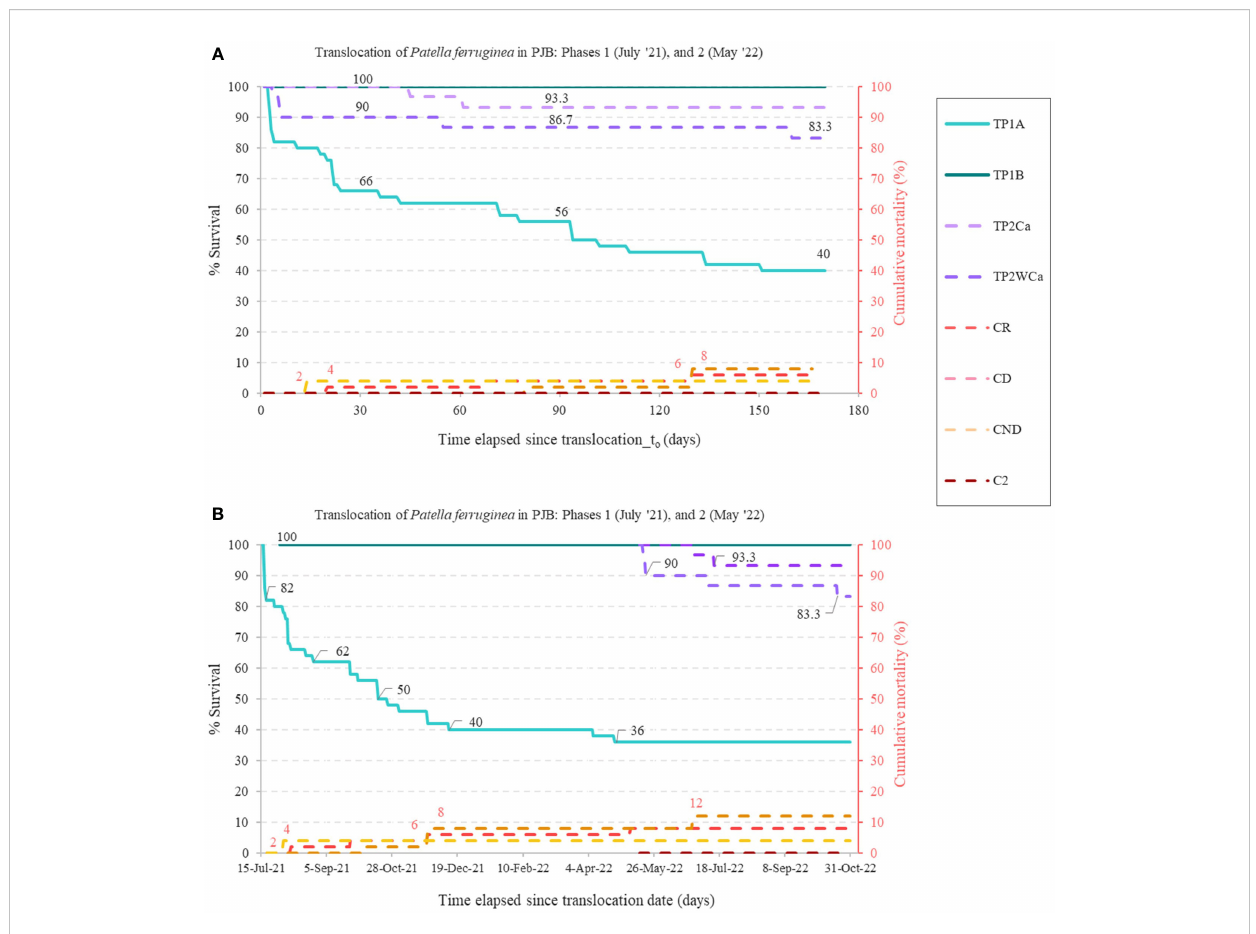
FIGURE 10 (A) , Integrated survival results for P1A (TP1A: Translocation phase 1A), P1B (TP1B: Translocation phase 1B) and P2 in specimens transferred with relocation with cage (TP2Ca) and without cage (TP2WCa), during the fi rst 5.5 months of the translocation, this time being the maximum monitoring time of P2 in this study (from 15 May 2022 to 31 October 2022); and (B) , shows the integrated survival results for P1 of 16 months (from 15 July 2021 to 31 October 2022) together with P2 since May 2023. The secondary axis represents the cumulative mortality of the control areas (CR, receiver control; CD, donor control; CND, non-donor control; C2, phase 2 control -0% in this case-). Number of limpets studied: NTP1A = 50; NTP1B = 3; NTP2Ca = 30; NTP2WCa = 30; NCR = 50; NCD = 50; NCND = 50; NC2 =